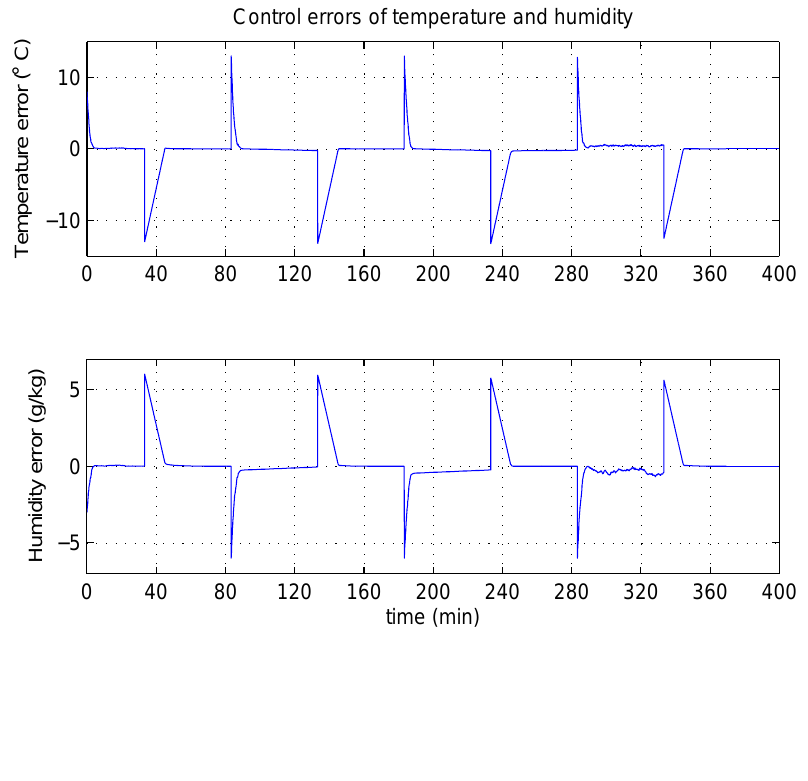
Figure 14. Variation of conventional PID control errors during the tuning